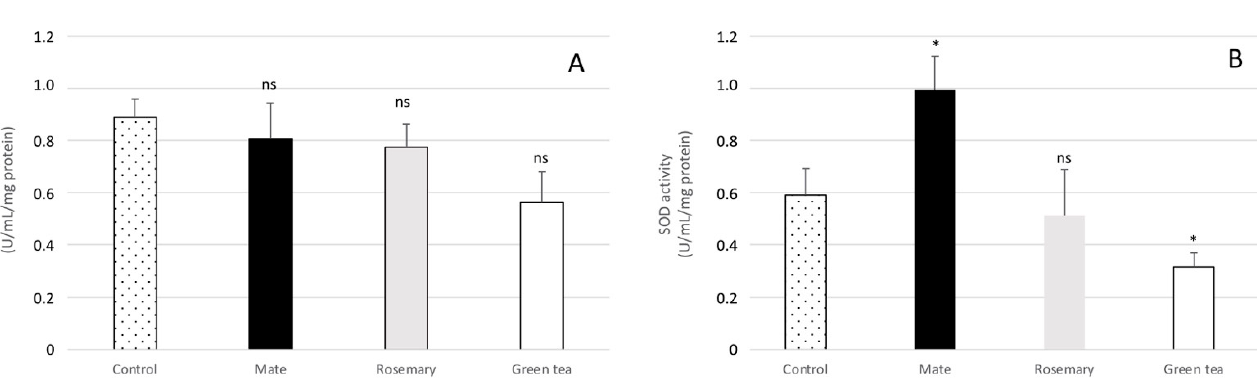
Figure 8. ( A ) Impact of plant extracts on the superoxide dismutase activity in A. flavus . The fungus was exposed to 0.225 mg DM/mL of culture medium of extracts of mate (black bars), rosemary (grey bars) and green tea (white bars) or ( B ) to IC80 of the three extracts corresponding to concentrations of 0.16, 1.11, 0.28 mg DM/mL of culture medium for mate, rosemary, and green tea, respectively. Control (bars with black dots) corresponds to superoxide dismutase activity in A. flavus culture with no extract. Results are given as the mean +/ − SD of six replicates. Significant differences with untreated control are indicated by * for p -value <0.05. ns: not significant.